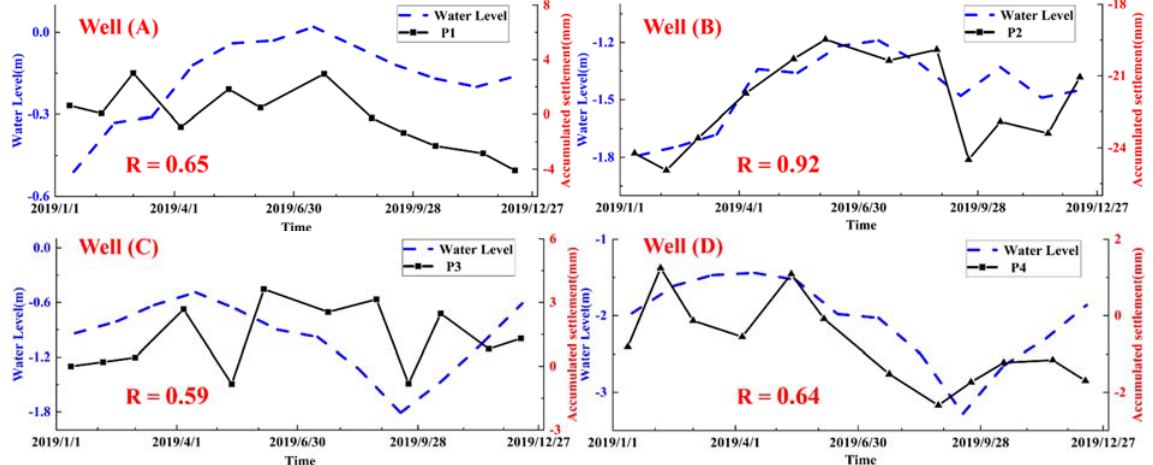
Figure 10. Time series of surface deformation and groundwater level change at multiple observation points.